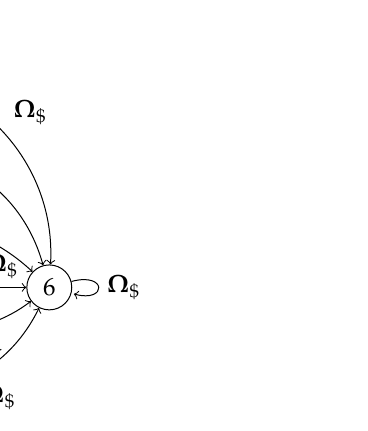
Figure 5. The handle-finding automaton for the specification Ξ in (2), constructed using G 1 .